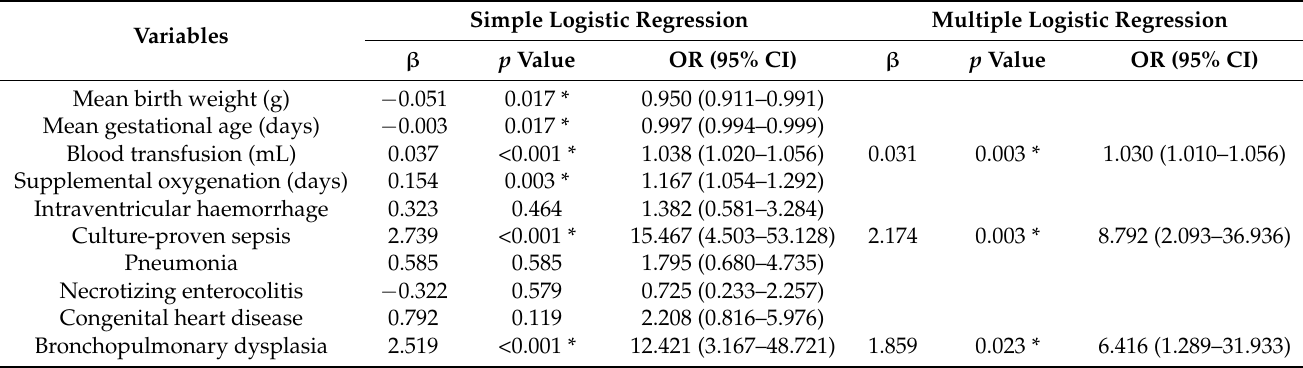
Table 2. Factors associated with